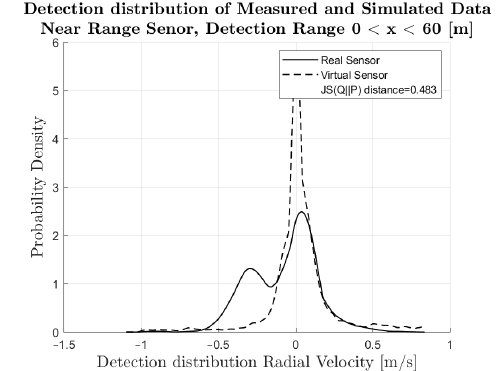
Figure 9. Evaluation of the detections in the range from 0 to 60 m of the near-range radar sensor and sensor model: PDF of the relative velocity in the x -direction from the reference velocity of the real sensor and sensor model.